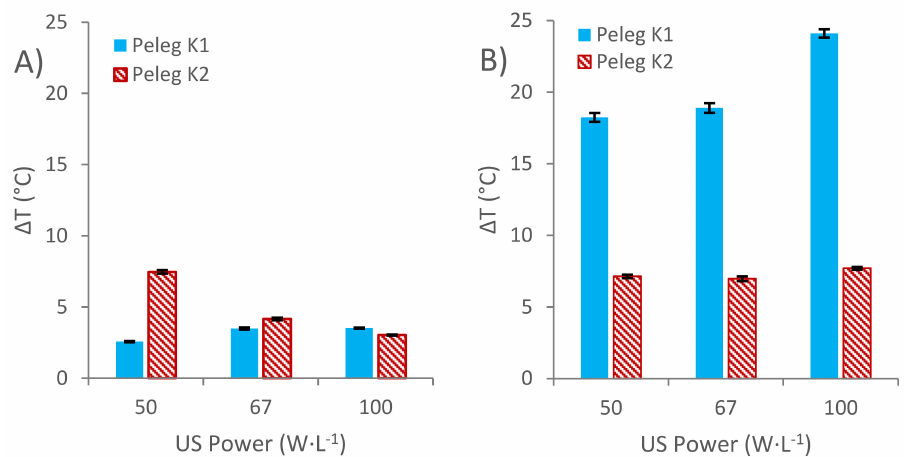
Figure 6. Temperature increments ( ∆ T) related to Peleg’s K 1 and K 2 constants at three different ultrasound power density levels: ( A ) non-pumped sonicated extractions (US-M) and ( B ) pumped sonicated extractions